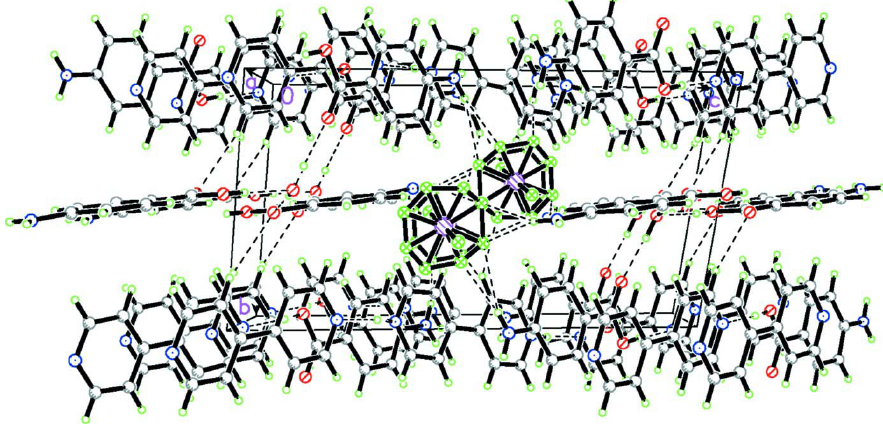
Figure 2 A view of the three-dimensional supramolecular network. Hydrogen bonds are shown as dashed lines. Hemi(4,4 ′ -bipyridinium) hexafluoridophosphate bis(4-aminobenzoic acid) 4,4 ′ -bipyridine monohydrate Crystal